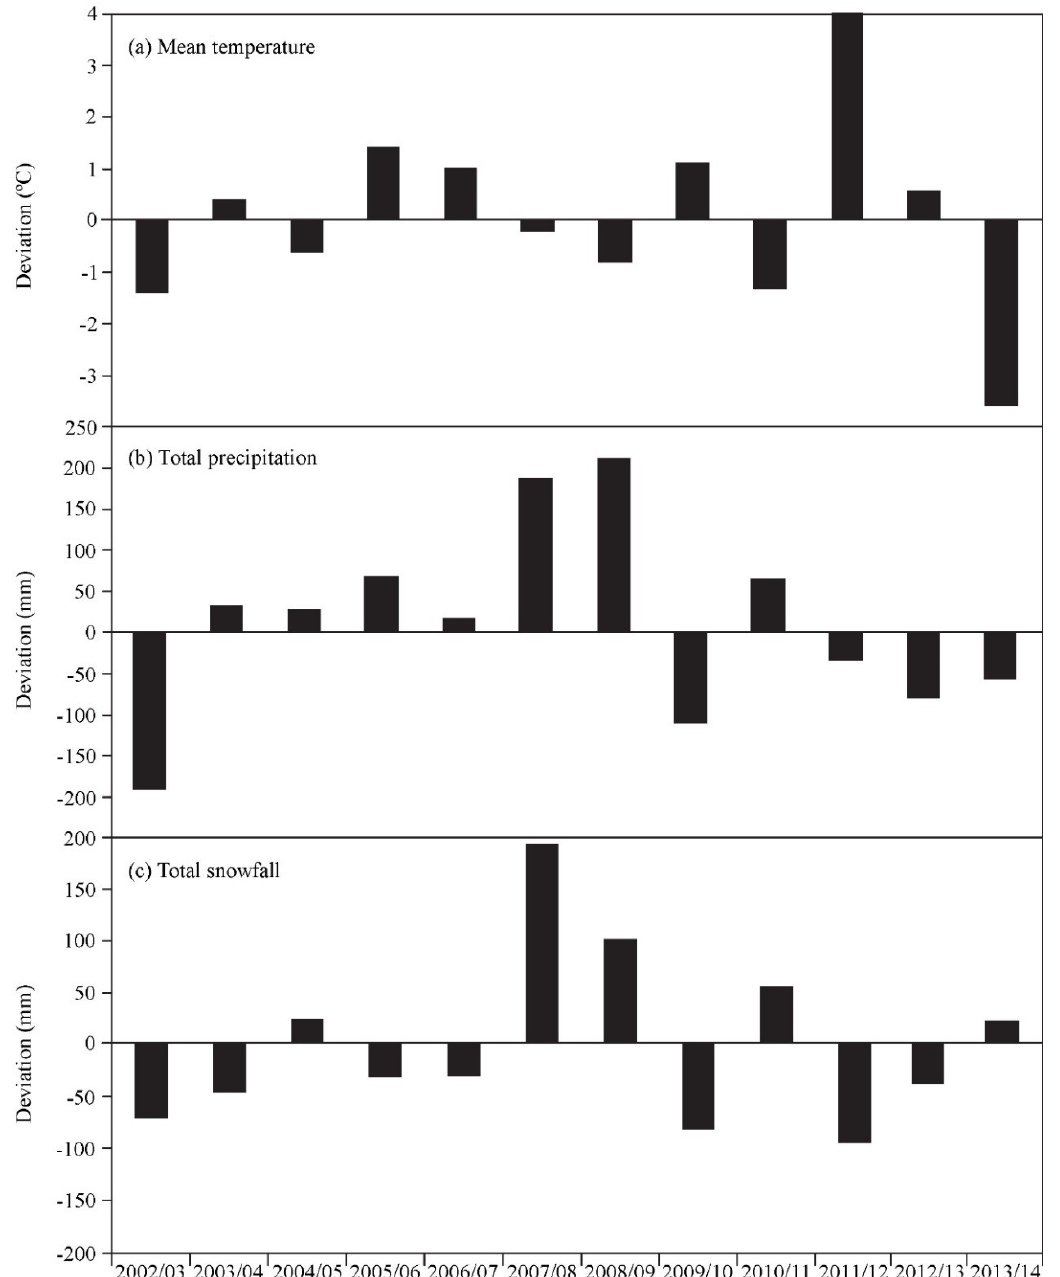
Figure 3. Deviations from the long term mean (1935 to 2014) for ( a ) mean winter temperature, ( b ) total winter precipitation and ( c ) total snowfall using the last twelve years of observed data from a weather station at Delhi,